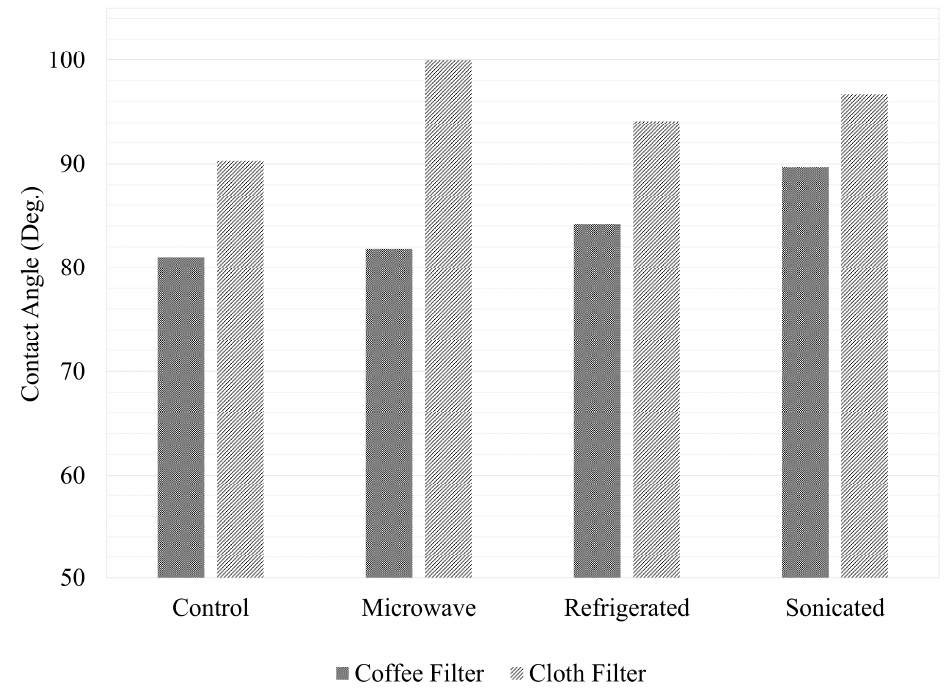
Figure 5. Contact angle of filters treated by different methods. Table 1. Porosity Ratio of Coffee Filter and Cloth Substrate.